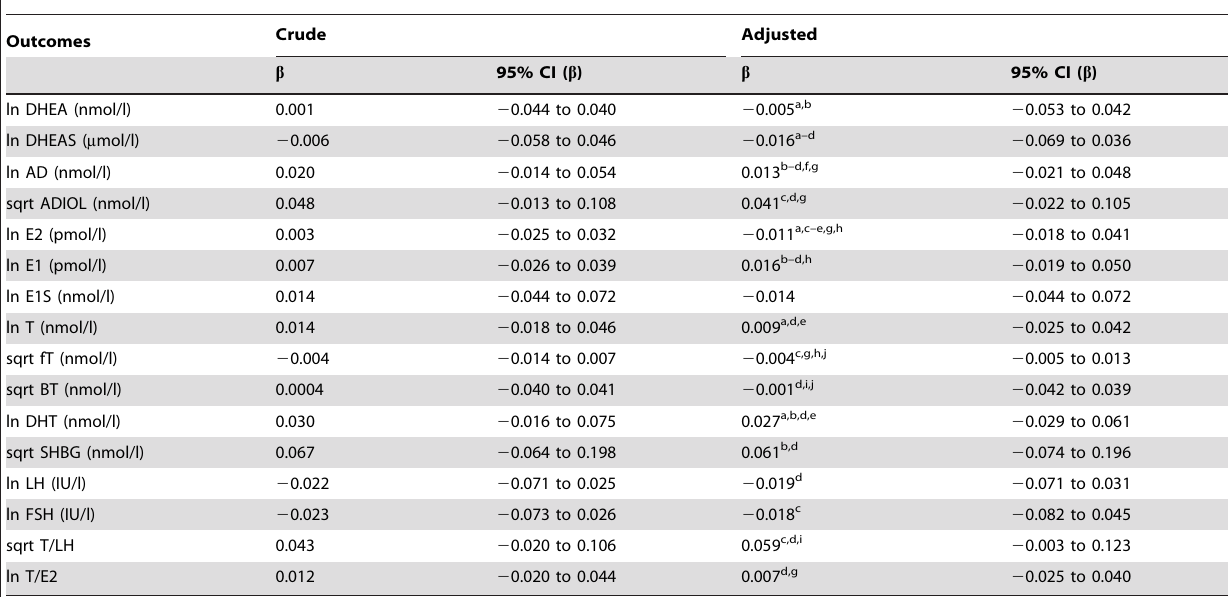
Table 5. Regression coefficients ( b ) for association between serum chlordecone levels and the outcomes variables.